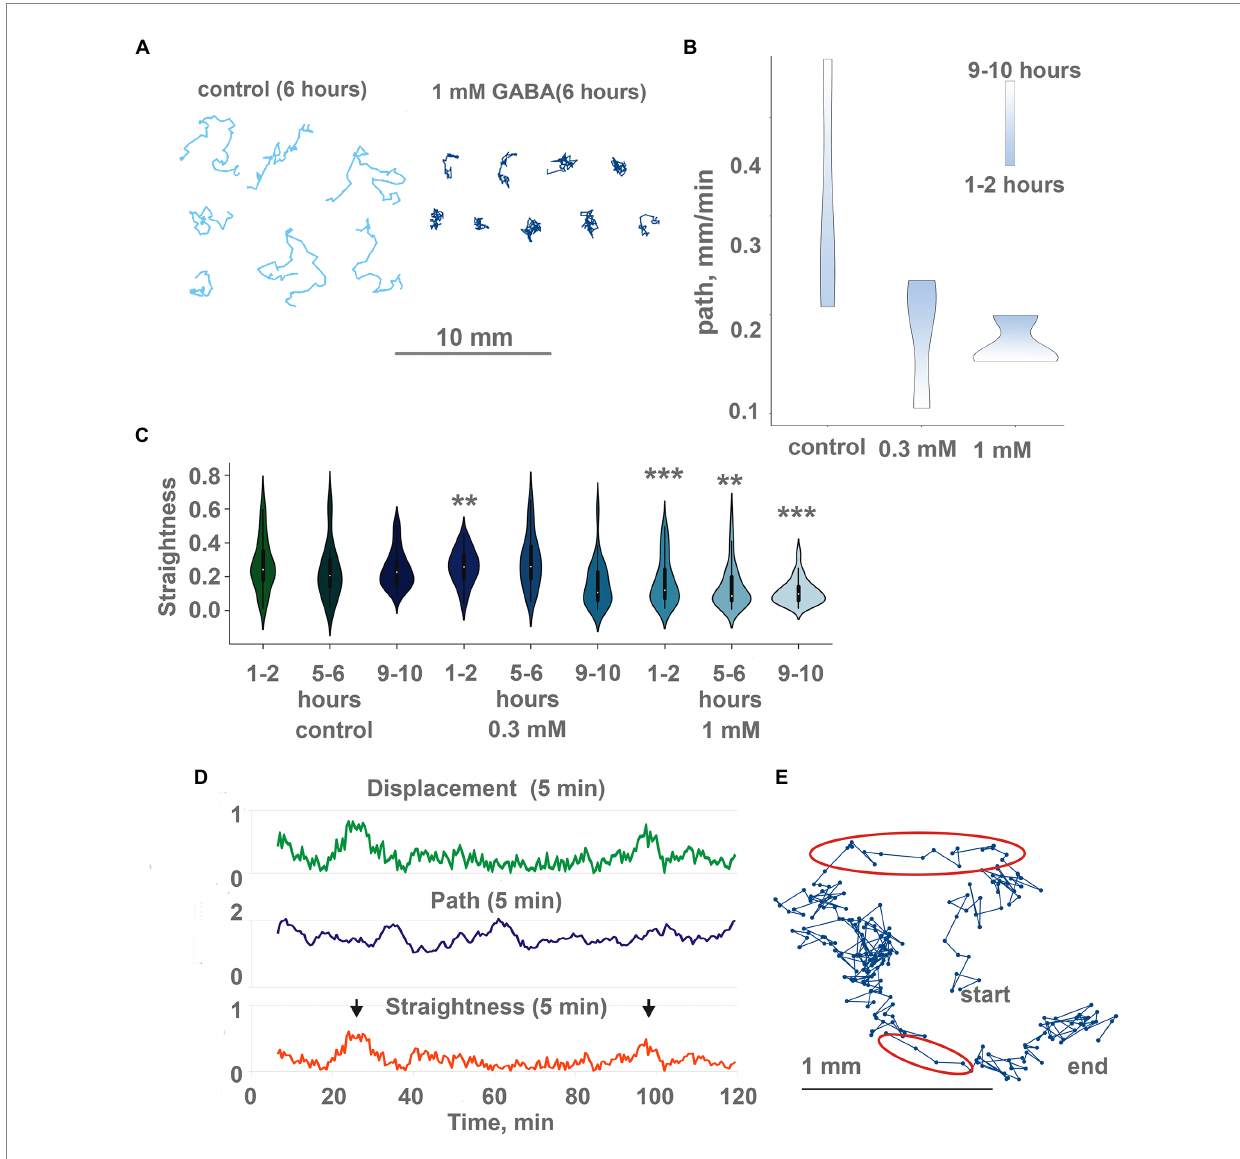
FIGURE 7 GABA modulate locomotion in Trichoplax adhaerens . (A) Tracks of animals incubated for 6 h in 1 mM GABA (right) and ASW (left). After GABA incubation, tracks are shorter and more squiggly compared to the control. Tracks were recorded for 60 min. (B) in native conditions, animals show increasing path length through time (from starting point to the destination), the additional concentration of GABA (0.3 and 1 mM) changes, and decreasing path. Individuals placed in the same locations for a long time (9–10 h). Scale bar: blue—1-2 h, white—9–10 h. (C) During incubation with GABA, track straightness gradually decreases, while in control, it is unchanged. Asterisks denote a significant difference in track straightness from the control (Welch t -test, ** p < 0.01, *** p < 0.001). N = 98, 50, 74, 29, 46, 69, 35, 44, 72. (D) Representative plot of displacement (green), track length (blue), and track straightness (red, displacement/length ratio) for 5 min periods for a single animal observed for 120 min on a conditioned Petri dish after 10 h in 1 mM GABA. Straightness and displacement are mostly low except for two periods at 25 and 100 min (arrows). (E) Track of the same Trichoplax as in Figure 6D with dots marking positions every 10 s, recorded for 120 min. Two periods of nearly straight movement are highlighted with red ellipses and correspond to straightness maxima marked by arrows in Figure 6D. Compare with a track of control animal in Figure